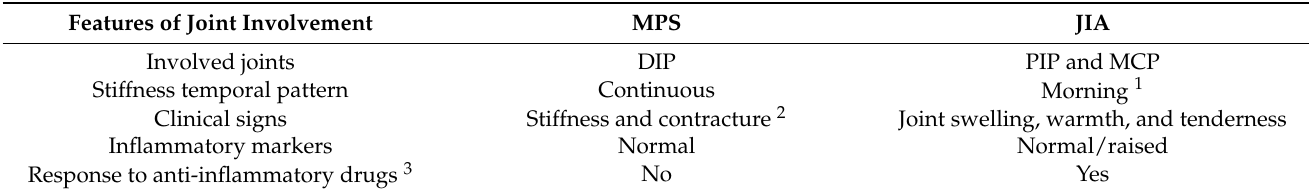
Table 4. MPS arthropathy vs. Juvenile idiopathic arthritis